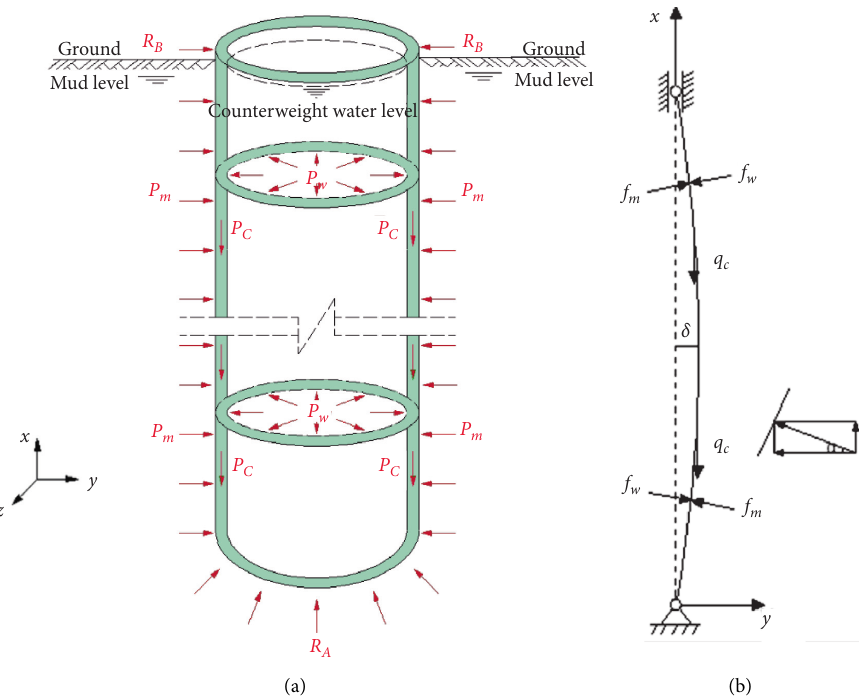
Figure 3: Mechanics model of equal-section drilling shaft lining full of water. (a) Force analysis sketch; (b) schematic diagram of stability